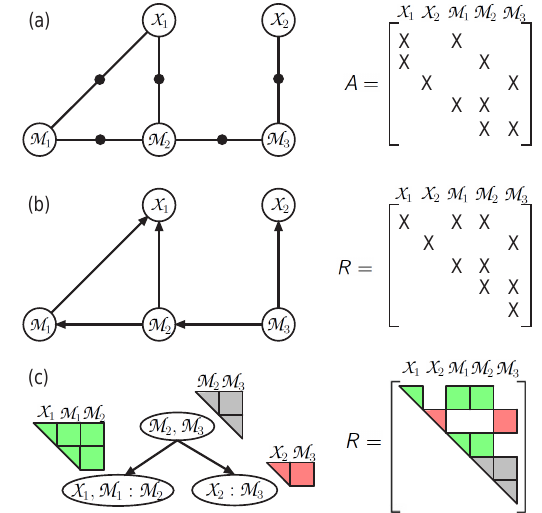
Figure 6: (a) A small exemplary factor graph and the associated Jacobian matrix A where scene points X 1 and X 2 are observed from the poses M 1 , M 2 and M 3 and odometry measurements be- tween the poses are given. (b) The so-called chordal Bayes net and the associated square root information matrix R result from factorization of the factor graph with the elimination ordering X 1 , X M M M 2 , 1 , 2 , 3 . The clique containing the last eliminated vari- able is called the root. (c) The Bayes tree and the associated square root information matrix R describe the clique structure in the Bayes net. The association of cliques and their conditional densities with rows in the R factor is indicated by color. Adapted from Kaess et al.